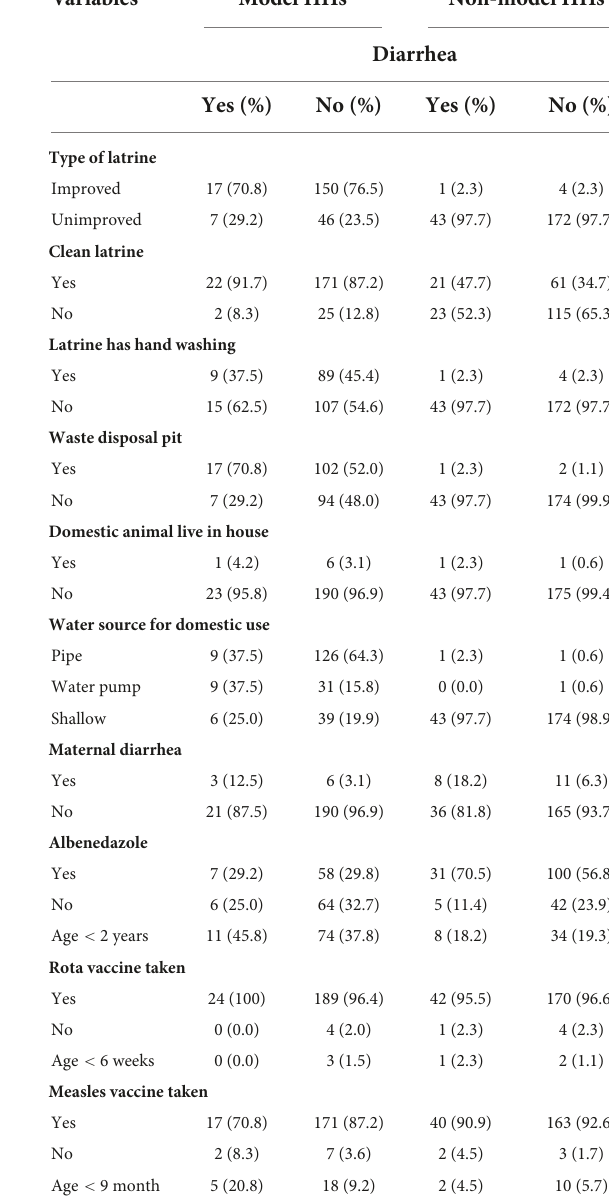
TABLE 2 Environmental and personal factors, and maternal and child health condition of respondents in Jawi district, Awi Zone, southwest Ethiopia,